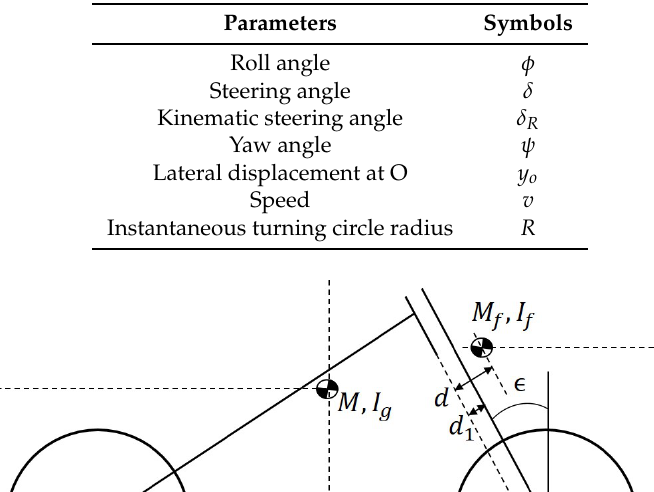
Table 2. Input and output parameters used in linear model.